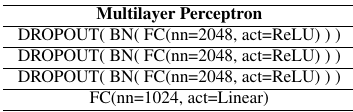
Table 4. Architectures of the Multilayer Perceptron (MLP)